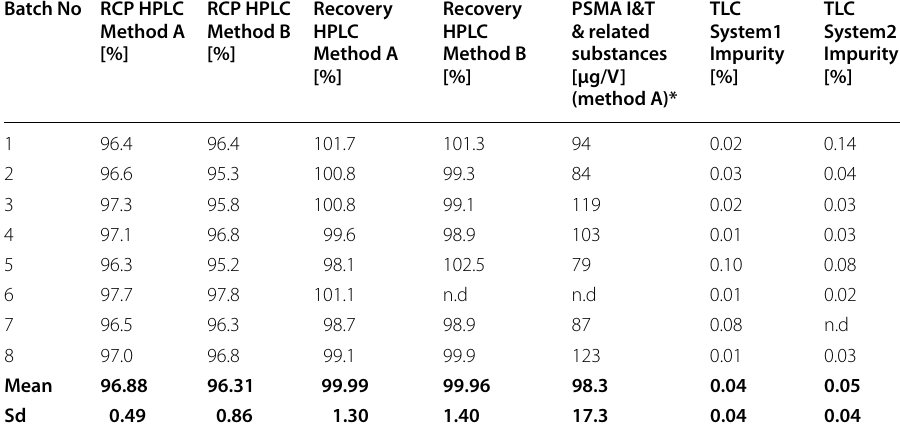
Table 2 Batch data (n